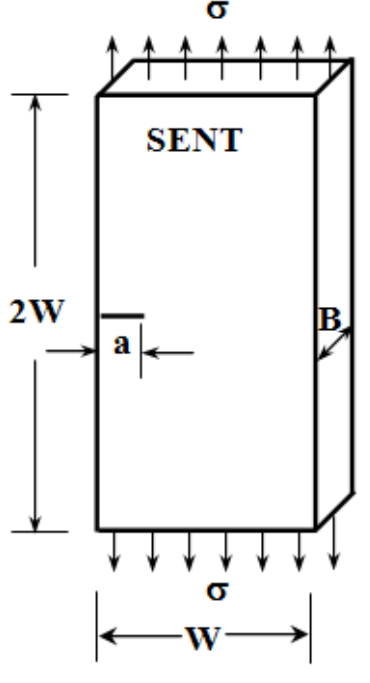
Figure1: Geometry of the specimen considered in the analysis.